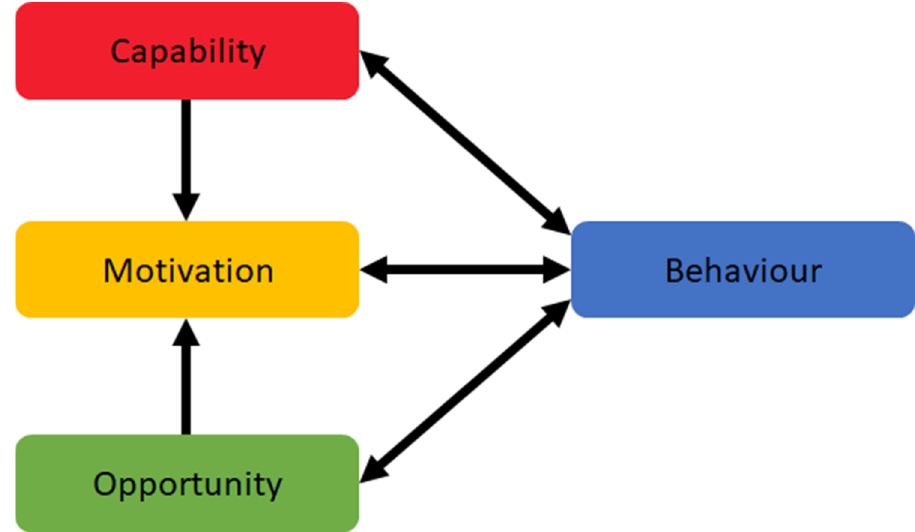
Figure 1. The COM-B Model (adapted from [51]).